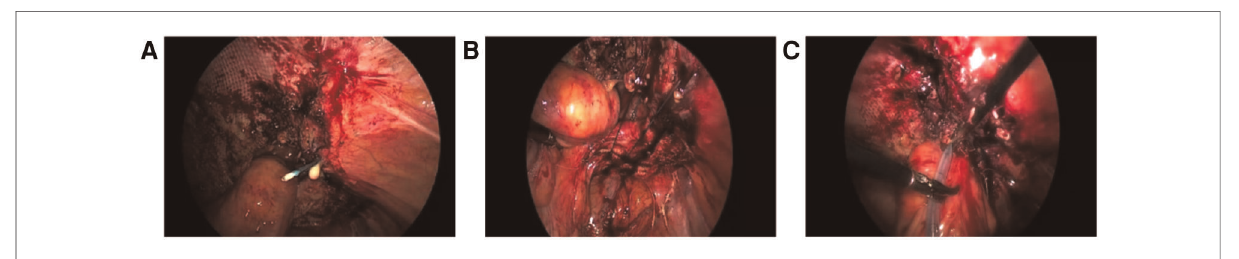
FIGURE 1 Flowchart of the surgical strategy.